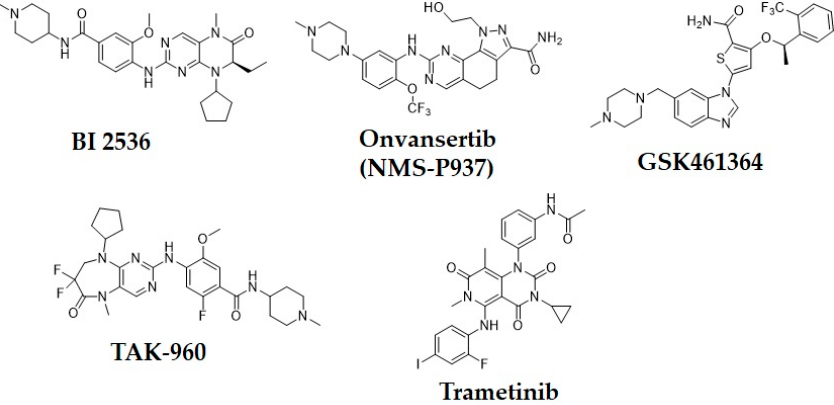
Figure 1. Chemical structures of the previously reported PLK1 inhibitors.